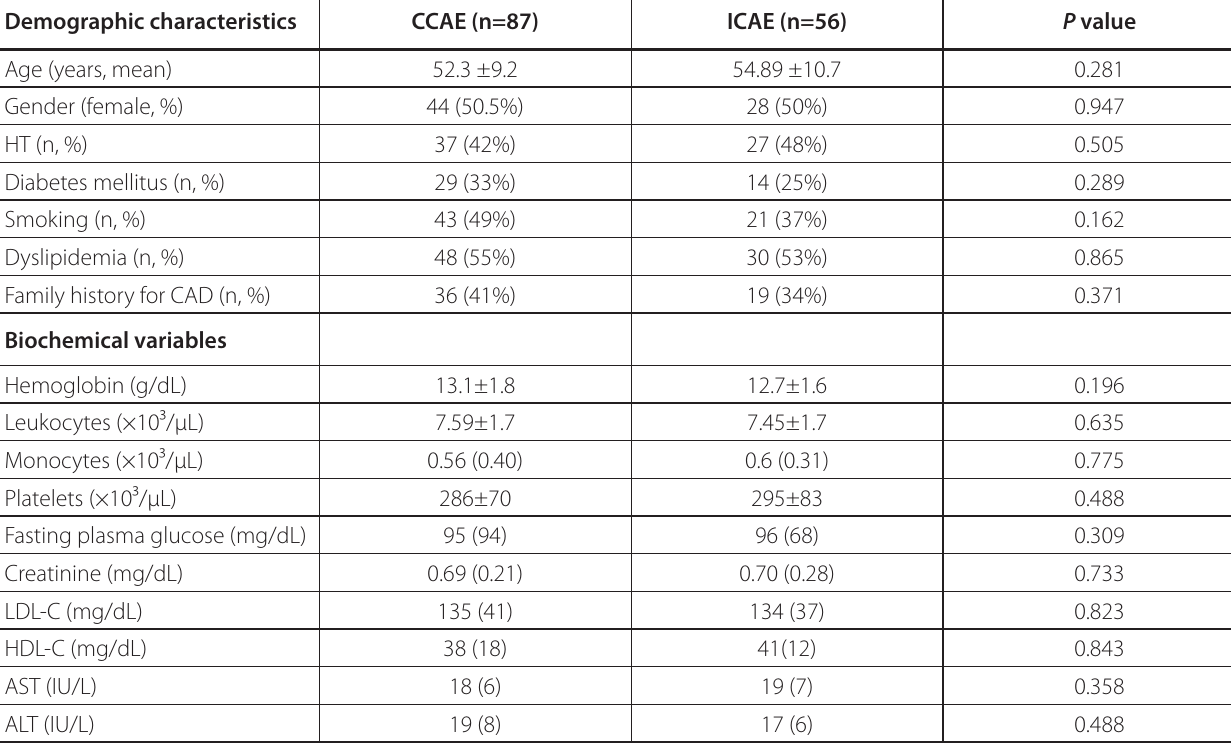
Table 2 . Baseline demographic characteristics and biochemical variables of the CAE groups. Demographic characteristics